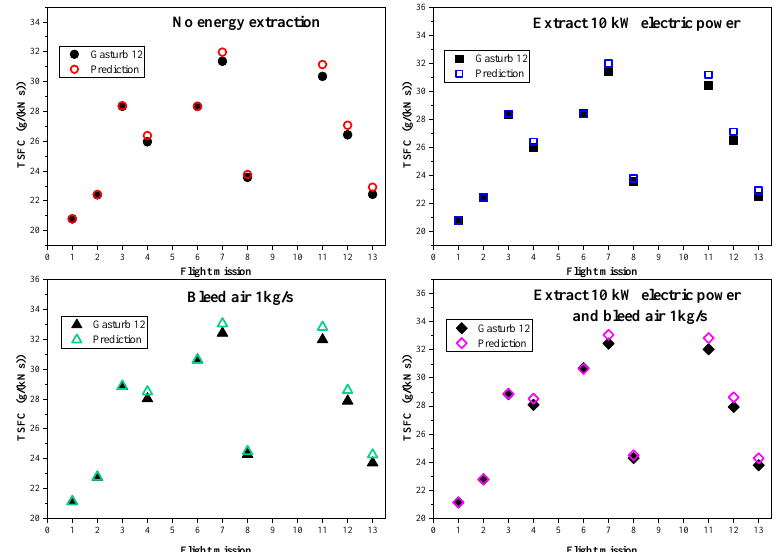
Figure 9. Comparison of TSFC calculation results.